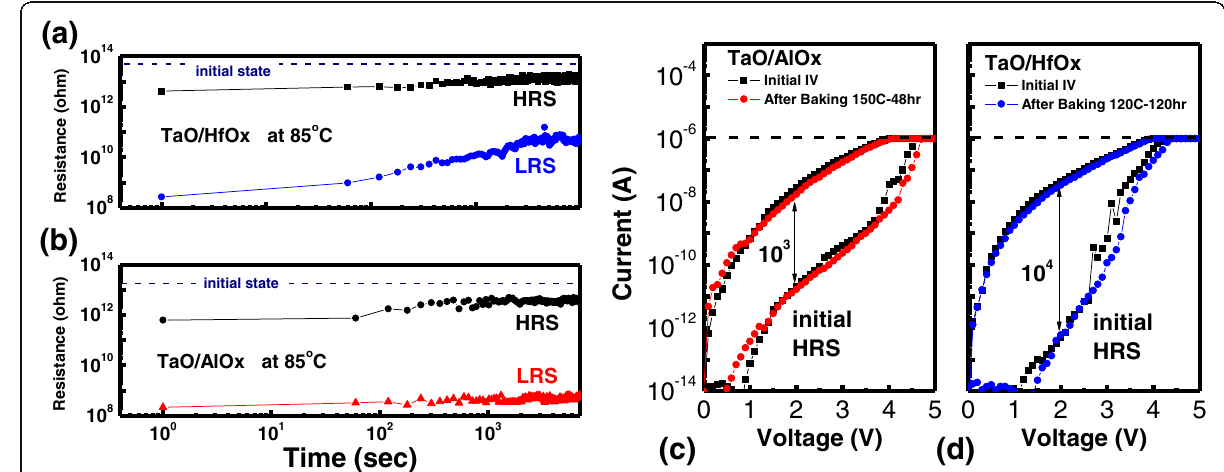
Fig. 3 Plots of resistance variation versus time for a TaO/HfO x and b TaO/AlO x devices. Both plots contain HRS and LRS variation at reading voltage = 1 V in 85 °C. After the I – V sweeps of each virgin device had been set, the device was baked and then programmed to LRS again: c TaO/AlO x (150 °C for 48 h); d TaO/HfO x (120 °C for 120